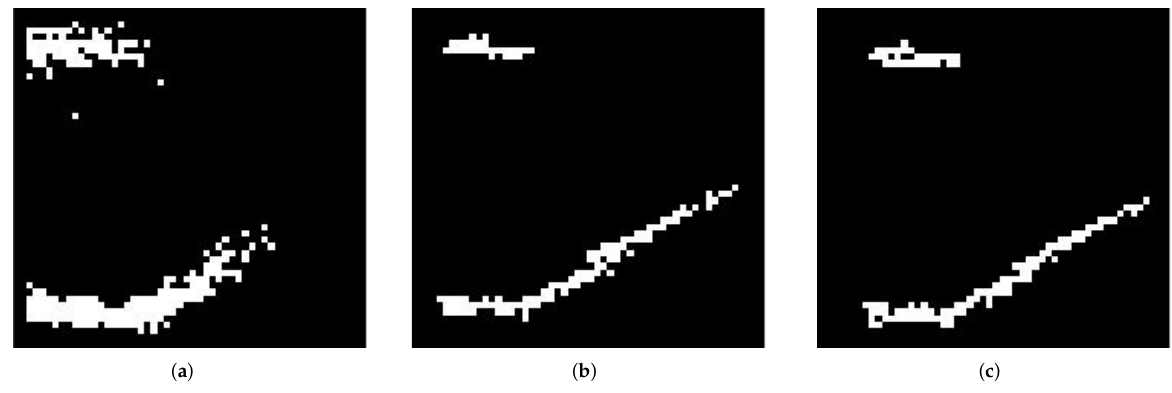
Figure 7. Effect of grid map matching. ( a ) Grid sub-map. ( b ) Scanning grid map. ( c ) Scanning grid map after